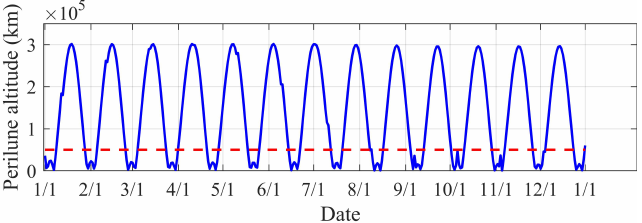
Figure 5. Transfer opportunity screened by the altitude deviation limit of perilune. The dotted lines indicate the preset perilune altitude deviation limit.